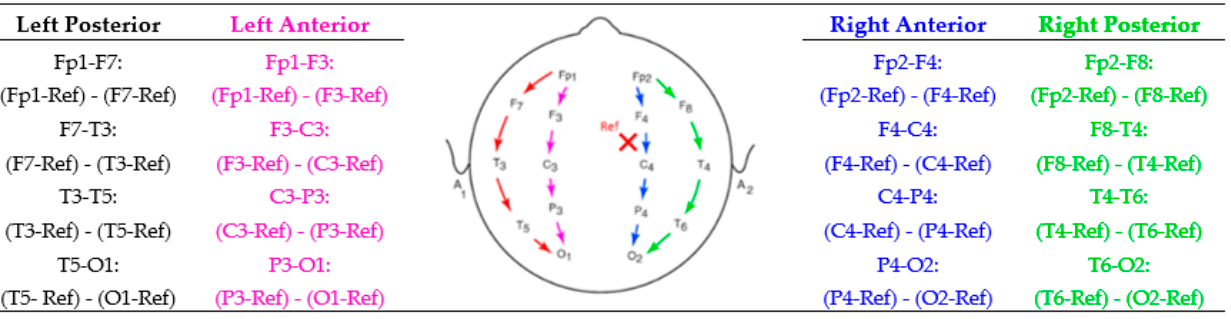
Figure 2. Longitudinal bipolar montage calculation separated in the left and right posterior and anterior areas.